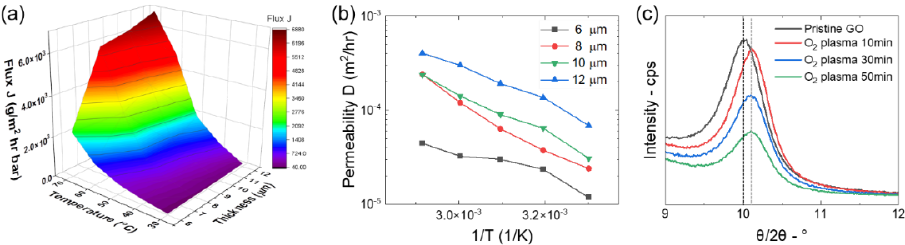
Figure 4. Permeability of a GO membrane to water as a function of membrane thickness and temperature. ( a ) Flux of water vapor through GO membranes with thicknesses varying from 8~12 µ m and temperatures ranging from 30 to70 °C. ( b ) Corresponding permeability values derived from ( a ). ( c ) XRD spectra of GO membrane before and after exposure to oxygen plasma